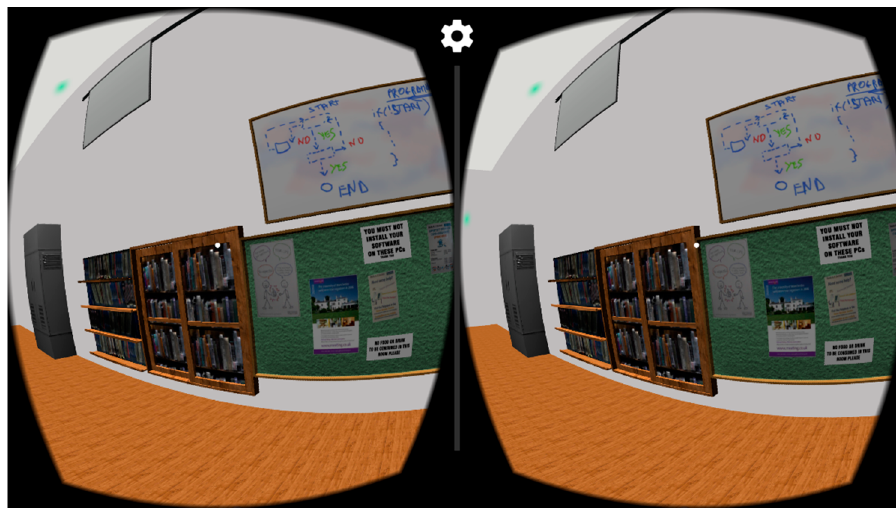
Figure 8. VoRtex virtual classroom (Android Google Cardboard view).